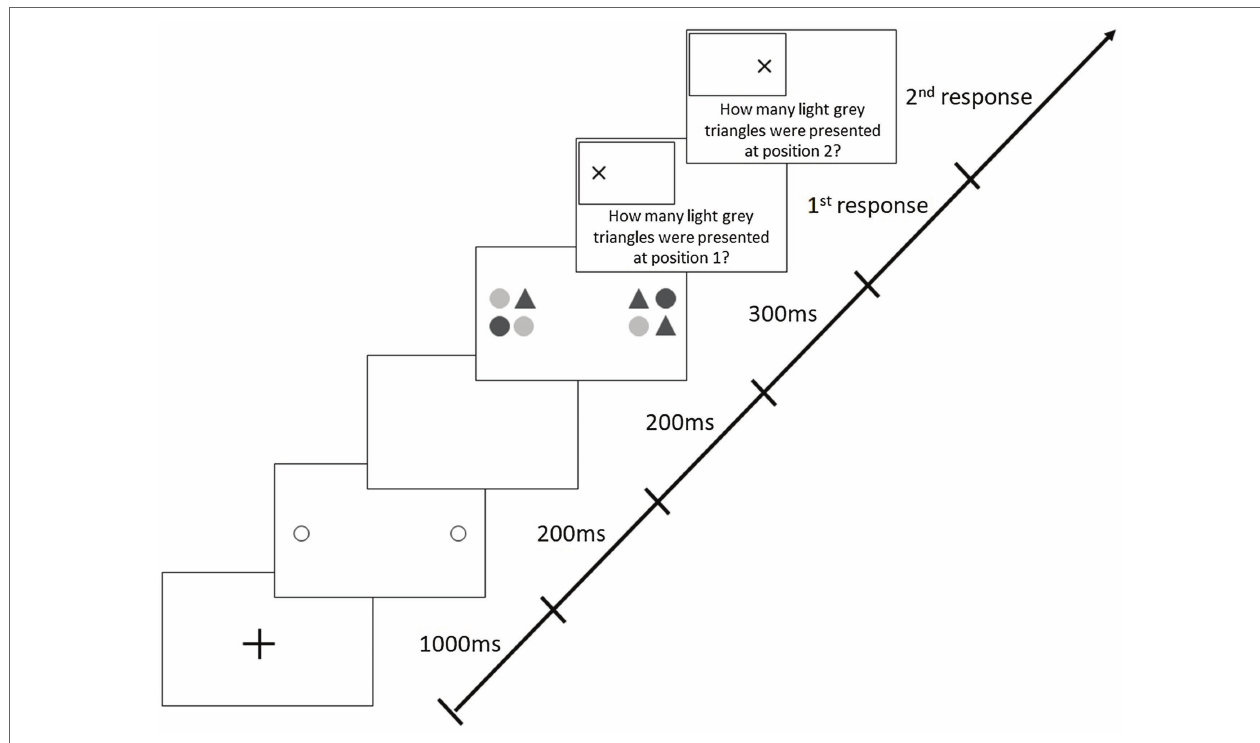
FIGURE 3 | Sequence of events in a trial with stimuli along the horizontal meridian in the original attention-window task (adapted from Klatt and Memmert,